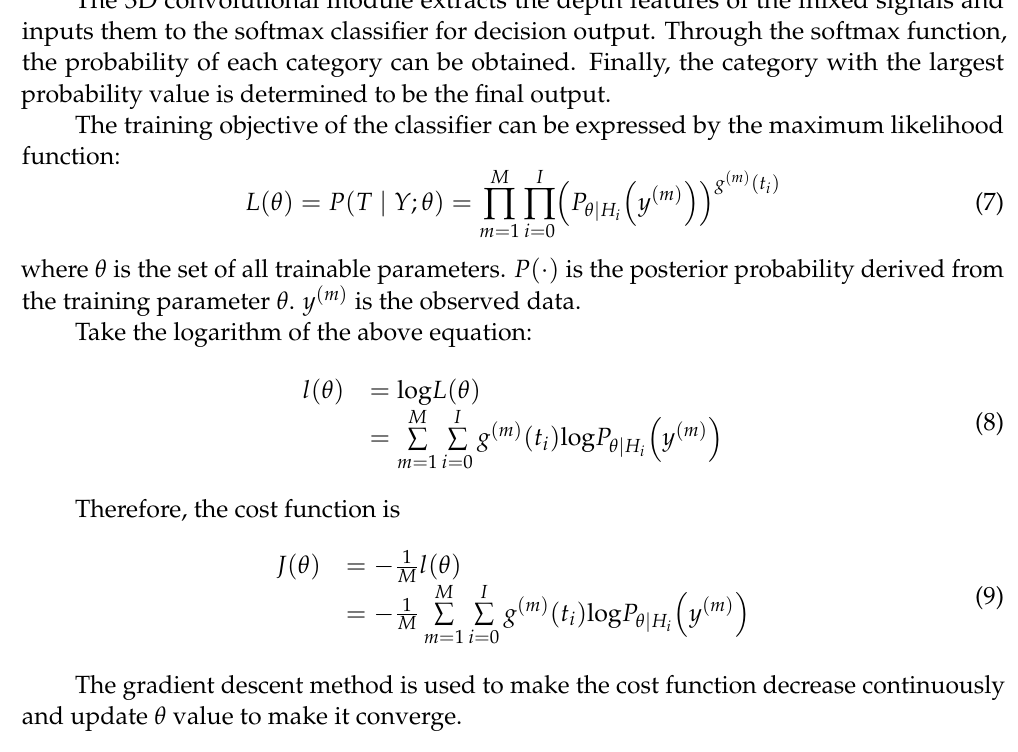
Figure 4. Number estimation network structure model.